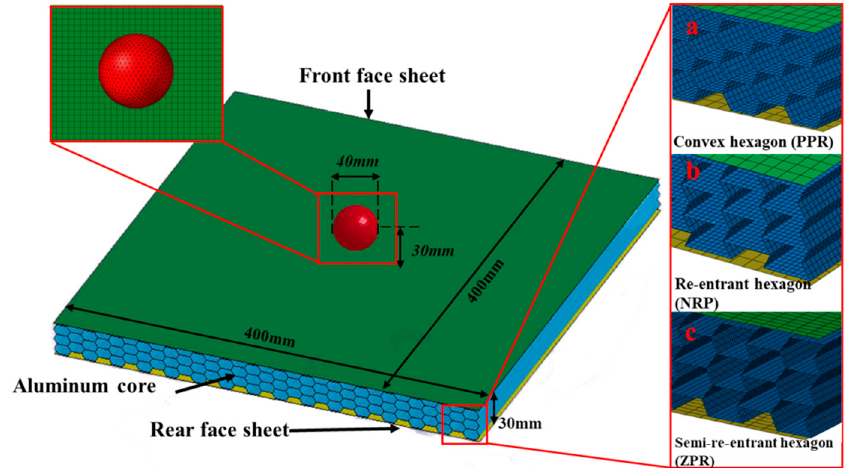
Figure 2. Finite element model of three types of honeycomb structures: ( a ) convex hexagon honeycomb with positive Poisson’s ratio; ( b ) re-entrant hexagon honeycomb with negative Poisson’s ratio; ( c ) semi-re-entrant hexagon honeycomb with zero Poisson’s ratio. The LS-DYNA V 971 software (ANSYS, Inc., Canonsburg, PA, USA) was used to